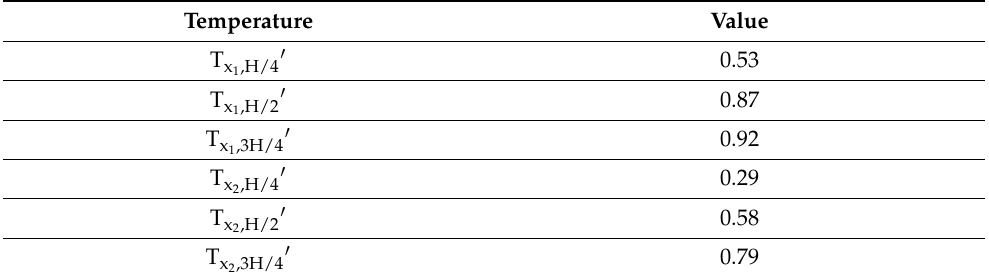
Table 3. Dimensionless temperatures in wells 1 (x 1 ) and 2 (x 2